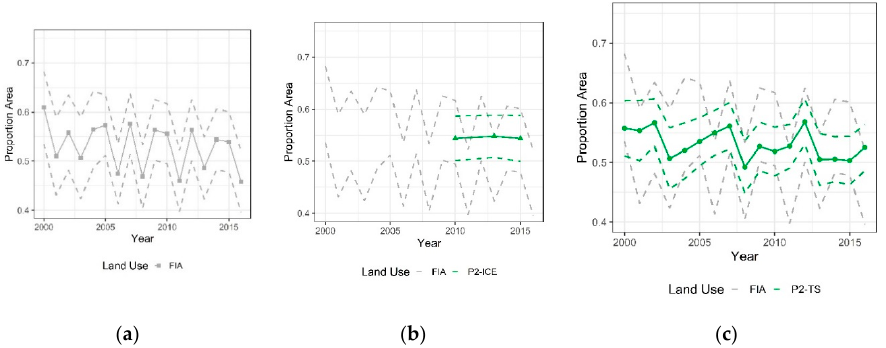
Figure 4. ( a ) Estimates of the proportion of land area in forest use derived with annual FIA data, ( b ) annual FIA data with ICE in phase 1, and ( c ) annual FIA data with TimeSync in phase 1 of a two-phase estimator. FIA estimates are shown as solid gray lines with confidence intervals as light gray dashed lines. ICE and TimeSync estimates are shown as green triangles and circles, respectively, with confidence intervals as dashed green lines.